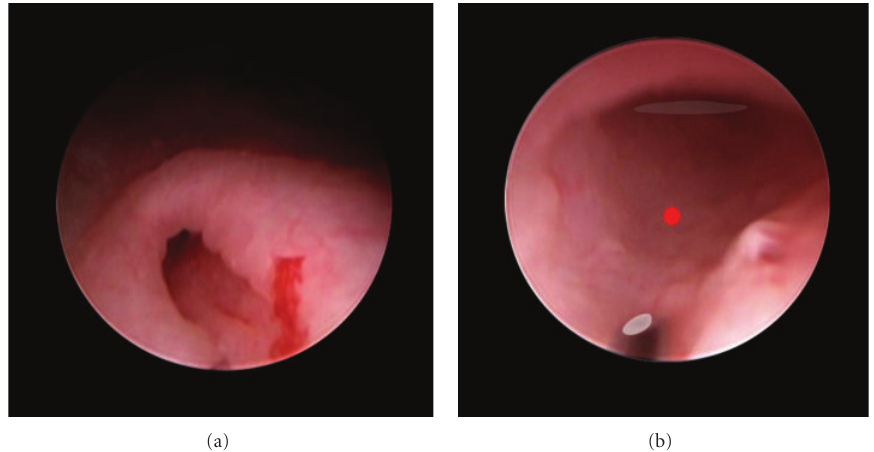
Figure 2: Procedure as CEVL components in a case of grade IV reflux in an infant girl. Enter the ureter orifice. (a) After hard/soft flushing of irrigation hydrodistends the ureter meatus such that the injection needle may enter tunnel. Alternative methods of entry are described in the electronically accessed module. (b) Needle tip (colored overlay) has entered tunnel and is positioned to inject at the halfway mark (red oval) between orifice (not shown) and detrusor hiatus (blue